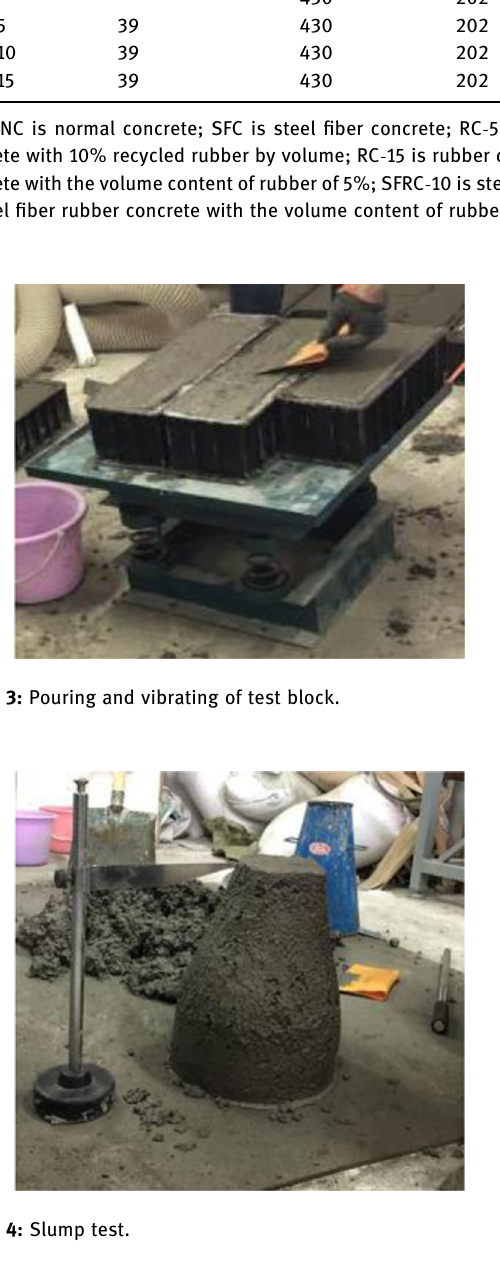
Figure 6: Slump of di ff erent concrete mix